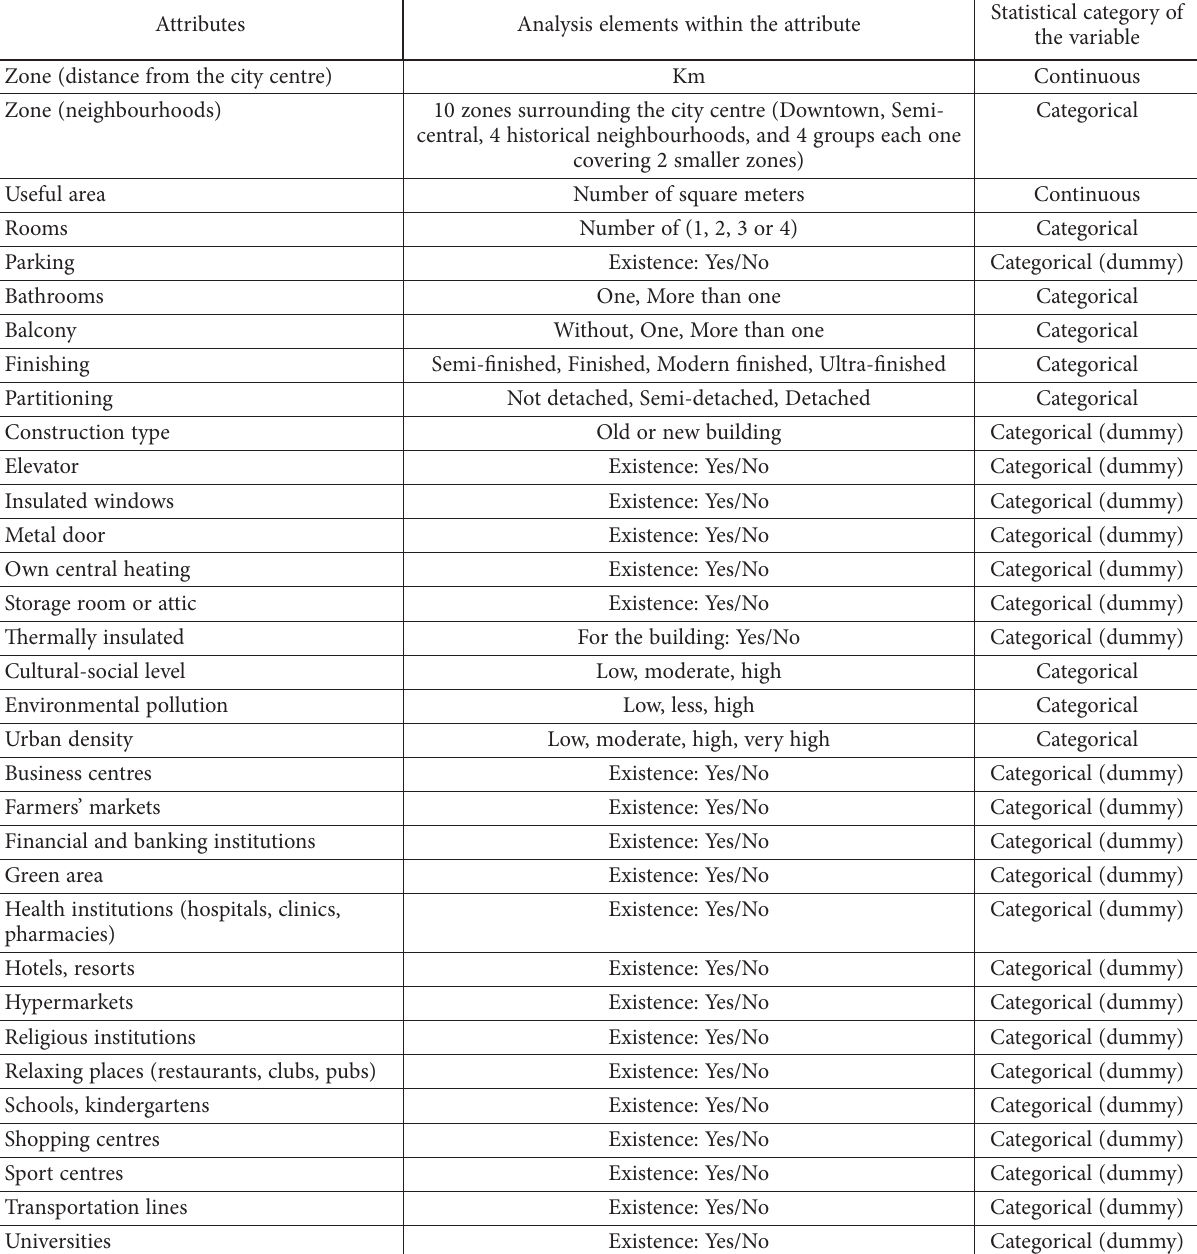
Table 3. Residential real estate